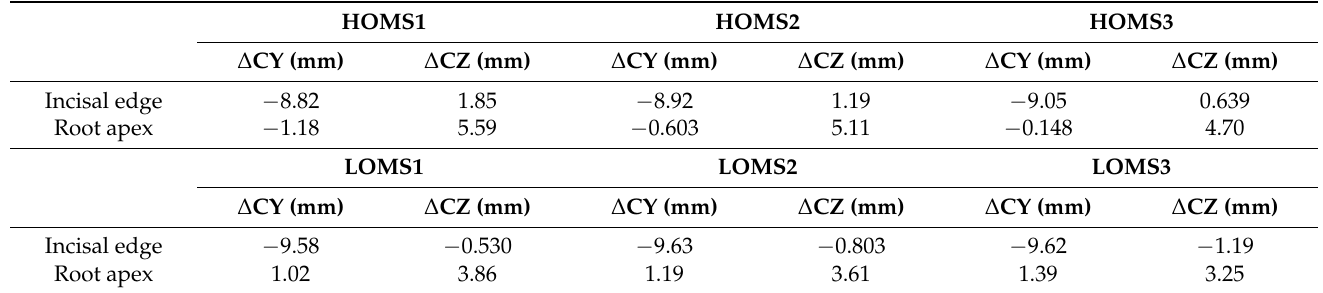
Figure 5. Changes in maxillary central incisor axis. Table 4. Incisal edge and root apex change in maxillary central incisor for each case.